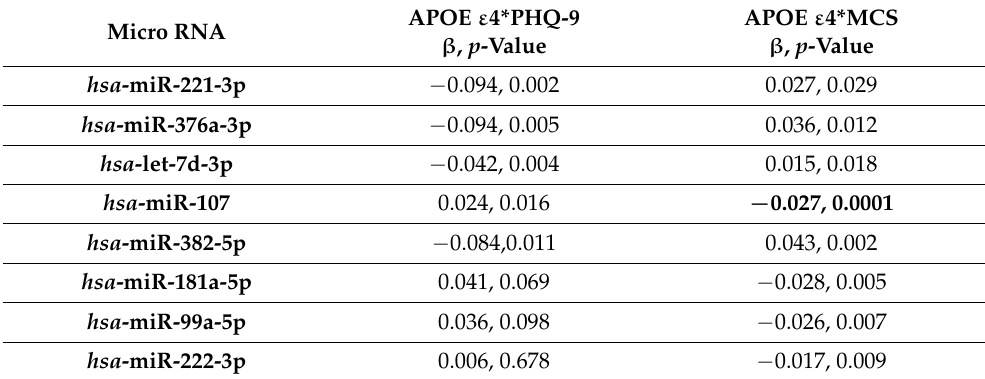
Table 6. Results of the interaction analyses (APOE ε 4*depression) for all miRNAs with a p -value <